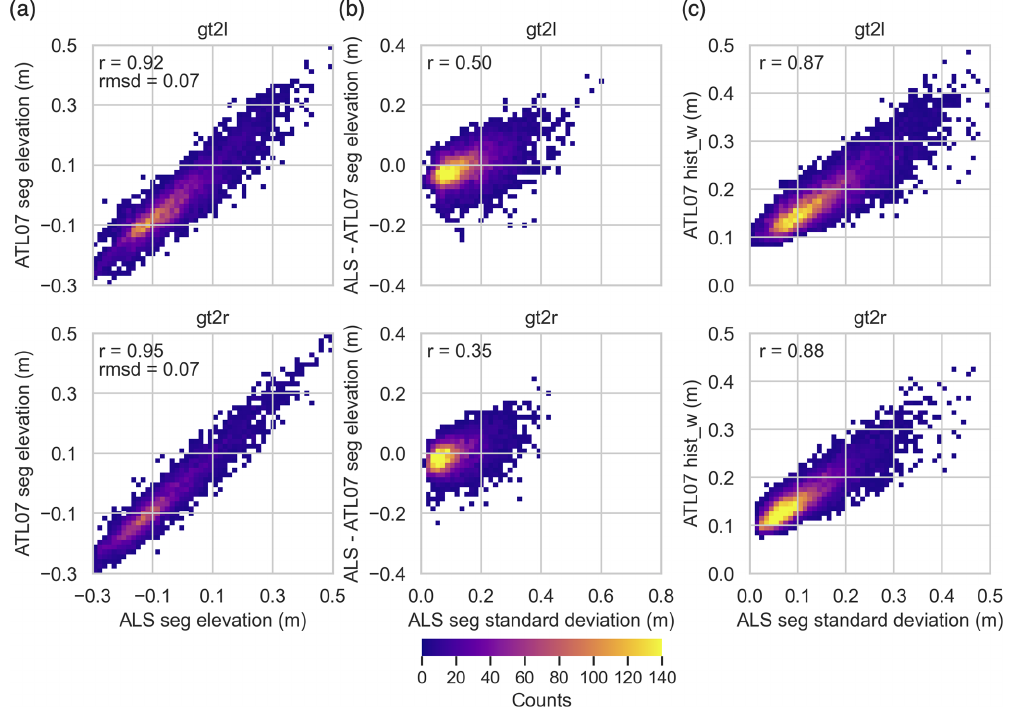
Figure 5. Scatterplots of co-registered ALS and ATL07 elevations: (a) comparison of segment-averaged elevations, showing the root-mean- square deviation (rmsd) and the Pearson correlation coefficient ( r ); (b) comparison between the ALS segment standard deviation and the difference between ALS and ATL07 segment elevations; and (c) comparison between the ALS segment standard deviation and ATL07 hist_w, representing the width of the height distribution within segments, provided in the ATL07 data product. Note that the rmsd refers to the elevations after subtraction of the long-wave correction (Sect.